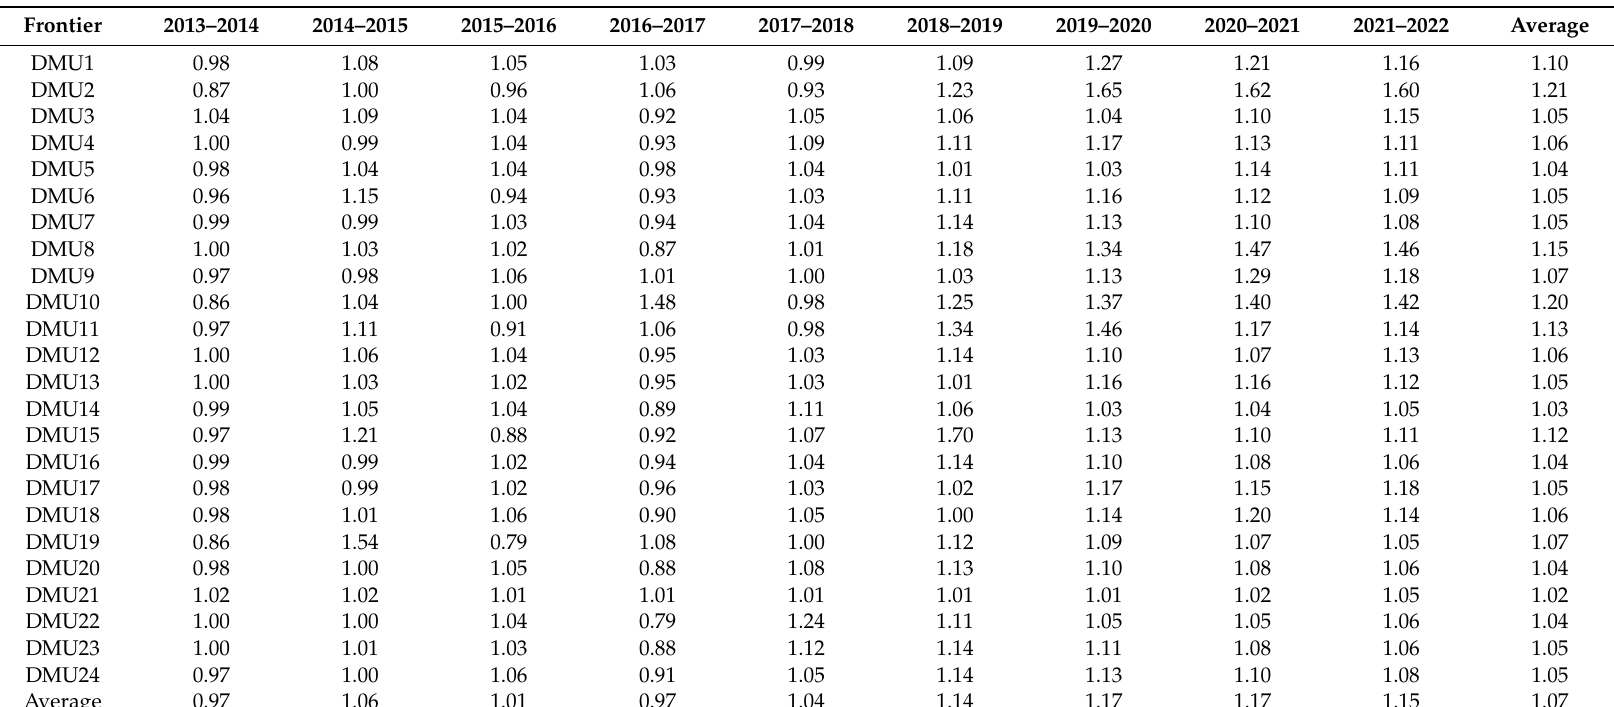
Table 7. The Frontier-shift